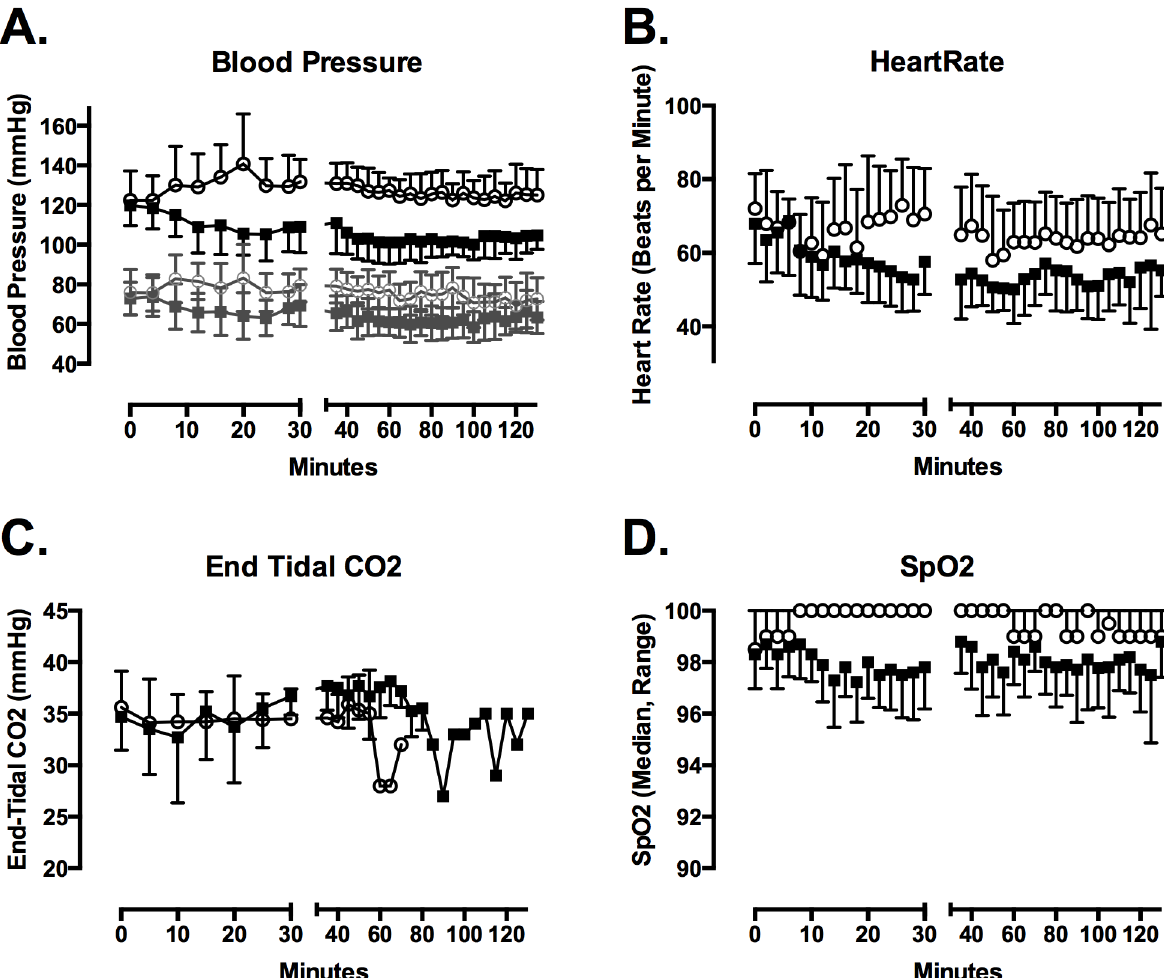
Fig 2. Dexmedetomidine infusion lowered SBP (A) and heart rate (B). In (A) systolic blood pressure is depicted in solid lines and symbols, while diastolic blood pressure is depicted in gray lines and symbols. End-tidal CO2 did not differ between groups (C). Pulse oximetry determined SpO2 was lower with dexmedetomidine, though the magnitude of the reduction was not clinically important (D). Figures depict mean with SD for blood pressure, heart rate and end tidal CO2. Median and range for SpO2 is depicted.